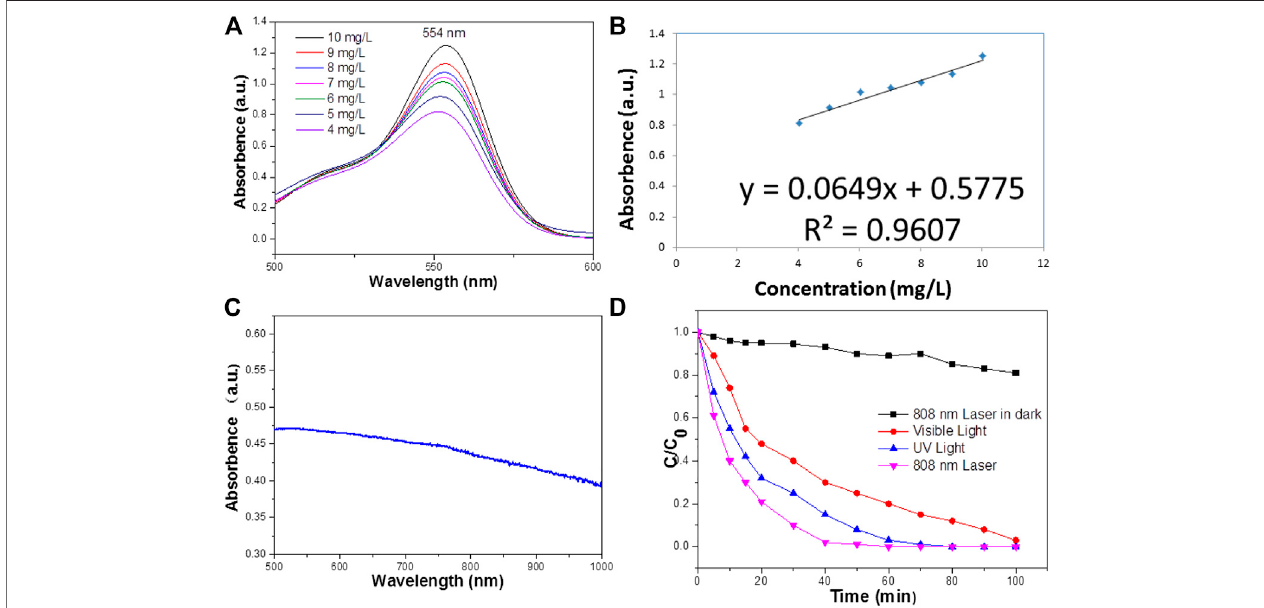
FIGURE4 | (A) SEM images ofthe Bi 2 S 3 nanocrystals in front of the laserirradiation. (B) Some SEM images of the Bi 2 S 3 nanocrystals after the laser irradiation. (C) Temperature condition of water and aqueous dispersions containing the Bi 2 S 3 NPs at 50 μ g/ml upon 808 nm in front of laser irradiation (1 W cm − 2 , 5 min). (D) Temperature condition of water and aqueous dispersions containing the Bi 2 S 3 NPs after the laser irradiation.